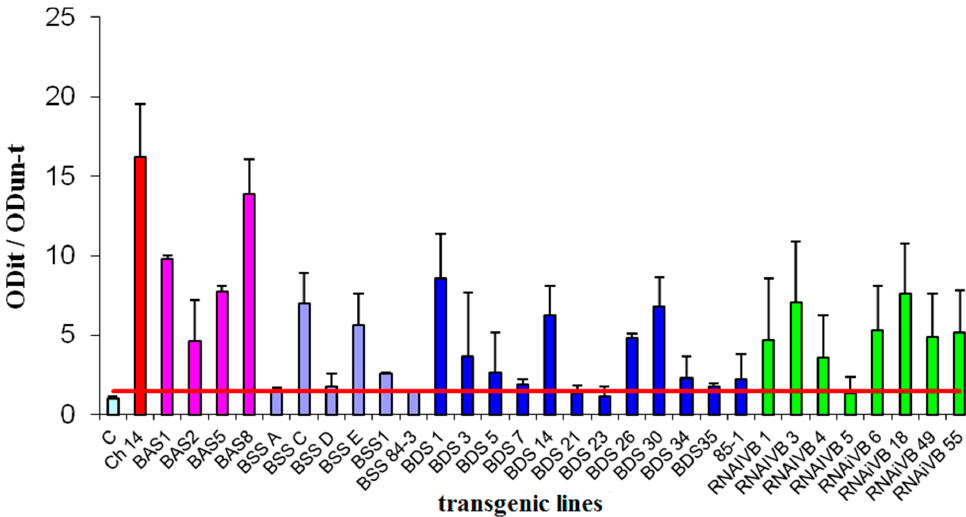
Figure 5. DAS-ELISA analysis of transgenic chrysanthemum plants infected with CVB. ODit/ODun-t denotes the ratio of the optical density of the samples obtained from the infected transgenic plants (ODit) to the optical density of uninfected non-transgenic plants samples (ODun-t). C—uninfected non-transgenic plant. Ch14—infected non-transgenic plants. The red line indicates the threshold value of the ratio ODit/ODun-t. Error bars indicate ± SD.